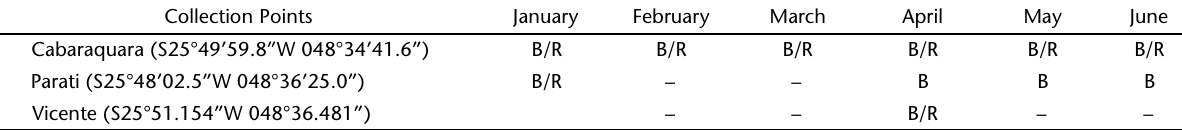
Table II. Location of collections in Guaratuba Bay (Paraná, Brazil) and the results of the analysis of plankton samples with the protocol devised to detect larvae of species of native Crassostrea spp. (by month 2010). (B) Sample positive for C. brasiliana ; (R) sample positive for C. rhizophorae ; (–) negative for larvae of both species. No samples of Vicente were obtained in January 2010. Collection